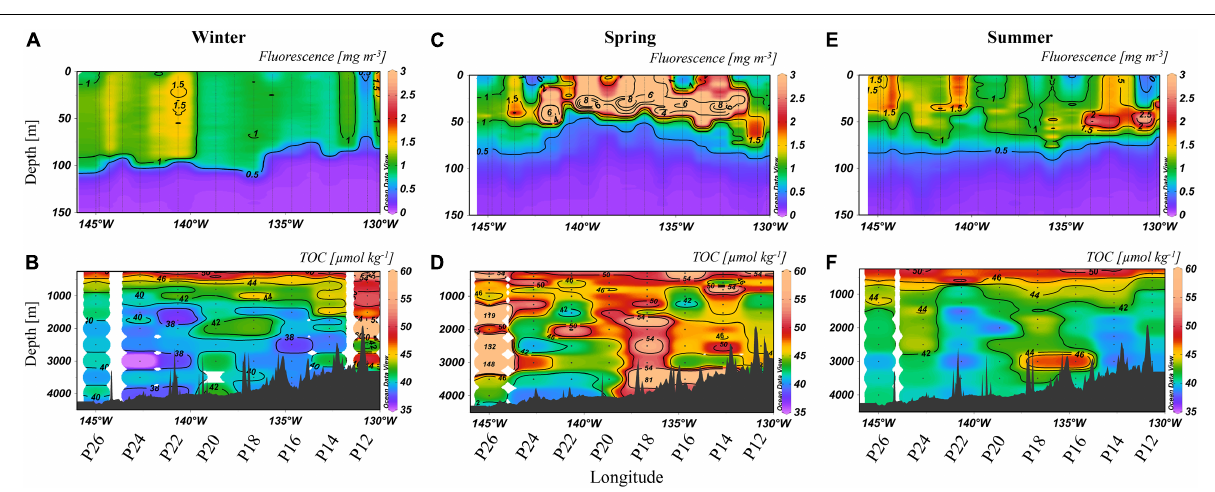
FIGURE 3 | Fluorescence to 150 m (A,C,E) [mg m − 3 ] and TOC [ µ mol kg − 1 ] at depths > 250 m (B,D,F) from 2018. The color scales are non-linear, with some values off scale ( > 60 µ mol kg − 1 for TOC, > 3 mg m − 3 for fluorescence). Note that fluorescence was measured at all stations while TOC was determined at selections stations, as labeled below the x